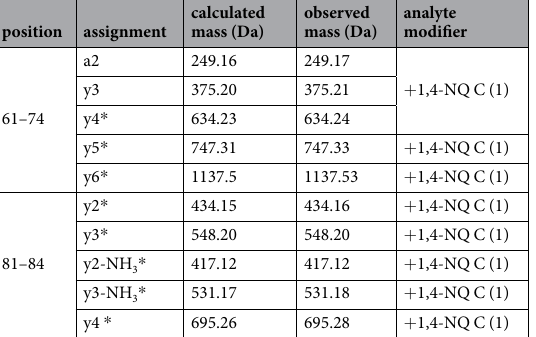
Table 1. MS E data for 1,4-NQ-modified peptides in human PTEN. Recombinant GST-tagged human PTEN